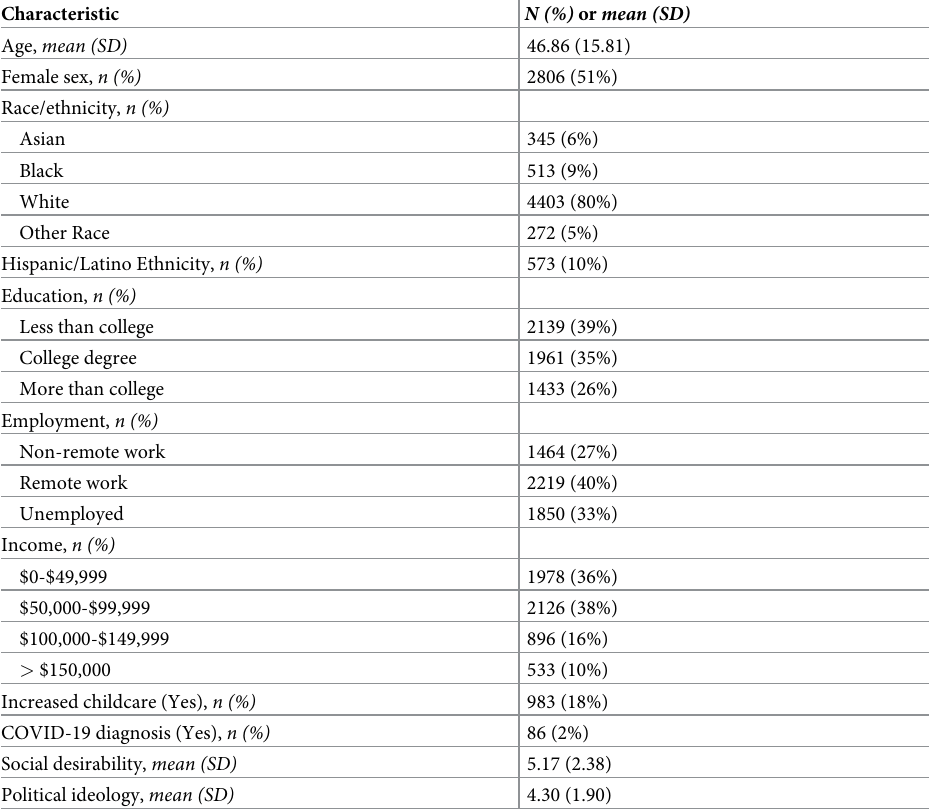
Table 1. Participant characteristics (March 2020 through July